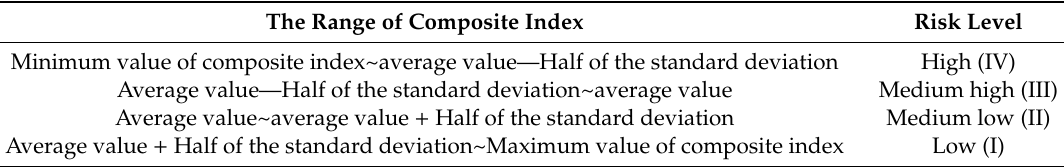
Table 6. Urban rainstorm risk and assessment index.